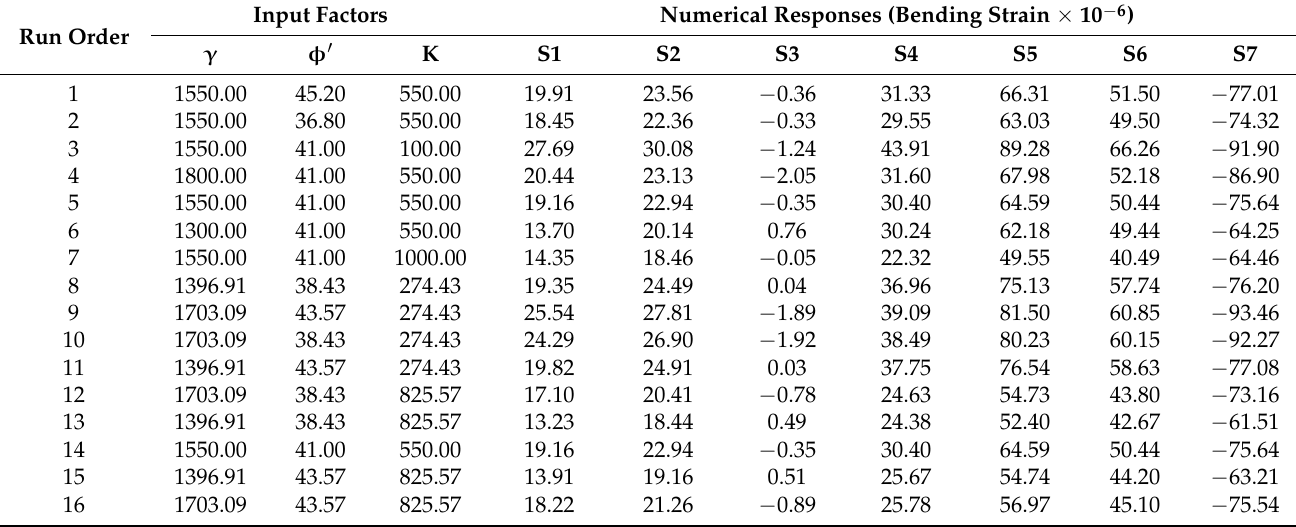
Table 2. Design of experiments and corresponding numerical responses.